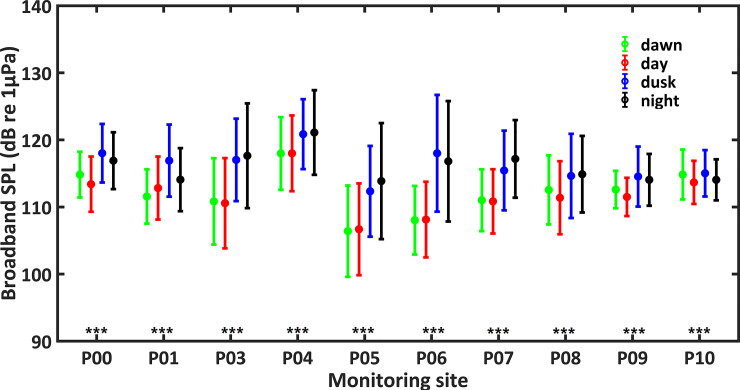
Daily trends of broadband sound pressure levels (broadband SPLs) during one year at the PAM sites.Differences among dawn, day, dusk and night are marked with *** for p-level < 0.001 (Kruskal-Wallis test).